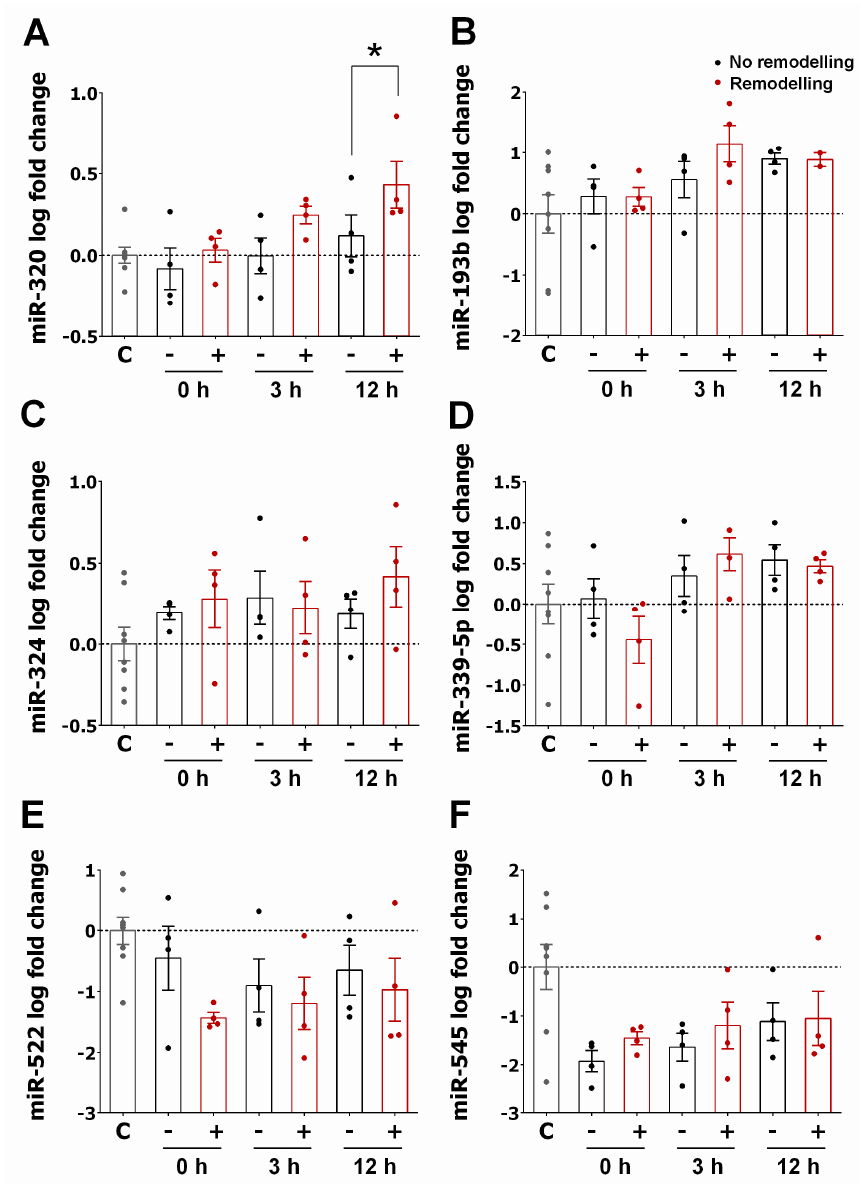
Figure 4. Comparison of the expression of miRNAs in patients with or without left ventricular adverse remodelling. ( A–F ) Bar graphs show the expression of miR-320a ( A ), miR-193b ( B ), miR-324 ( C ), miR-339-5p ( D ), miR-522 ( E ), and miR-545 ( F ) in serum samples of STEMI patients who developed left ventricular adverse remodelling (red bars, n = 4) or not (black bars, n = 4) before PPCI (0 h) and at 3, 12, and 24 h after the procedure. The values in the graphs represent the fold change in logarithmic scale for each miRNA relative to controls. Values are presented as the means ± SEM and represent the fold change in logarithmic scale for each miRNA relative to controls ( n = 8). Significance is indicated by (*) for p < 0.05. Ordinary one-way ANOVA with multiples comparisons using T-test without correction (Fisher’s LSD test) was performed.